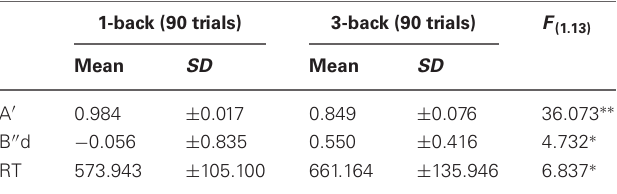
Table 1 | Means scores and standard deviations in the 1-back and 3-back tests.